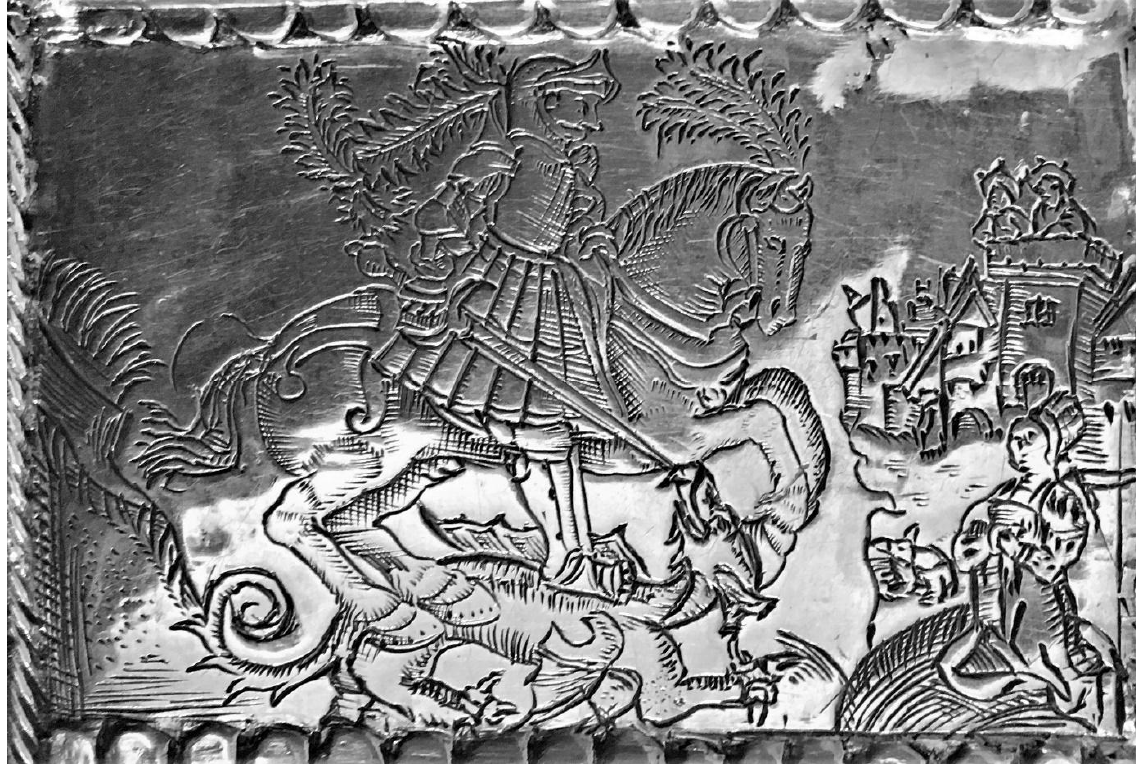
Figure 7. Closeup of the St George panel from the top rear of the Barber Surgeon’s instrument case. Worshipful Company of Barbers.